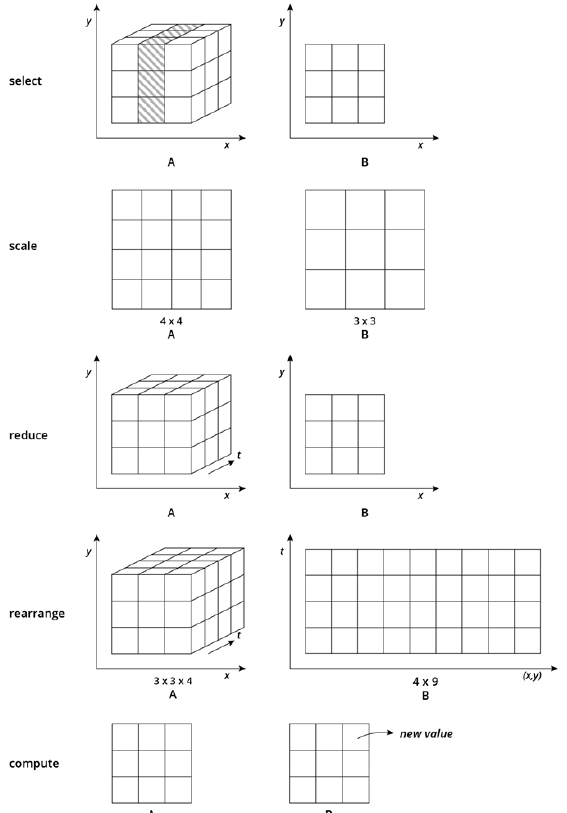
Figure 2. Array operations. “A” indicates original arrays, “B” indicates result arrays after certain array operations are applied (Lu et al.,